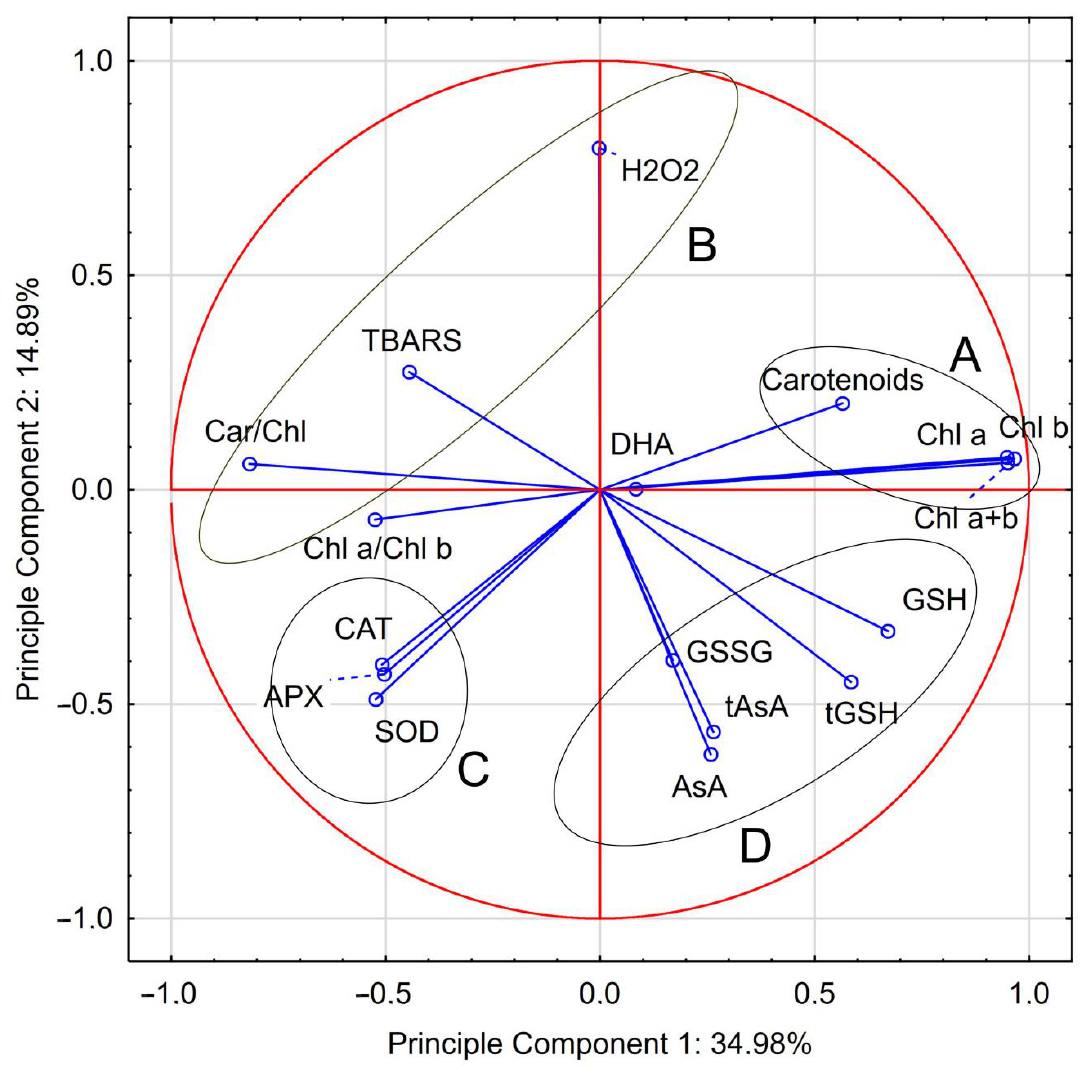
Figure 9. Principal component analysis of senescence markers, oxidative stress markers, and antioxidative system activity markers of the sun and shade beech leaves. The first two principal components are plotted. The components allowed the distinction between three groups of metabolites: group A consisted of leaf pigments (Chl a — chlorophyll a, Chl b — chlorophyll b, and carotenoids), group B consisted of oxidative stress markers (H 2 O 2 — hydrogen peroxide, TBARS — thiobarbituric acid-reactive substances, and Car/Chl — carotenoid/chlorophyll ratio), group C consisted of small-molecule antioxidative compounds (tAsA — total ascorbate, AsA — reduced ascorbate, tGSH — total glutathione, GSH — reduced glutathione, and GSSG — oxidized glutathione), and group D consisted